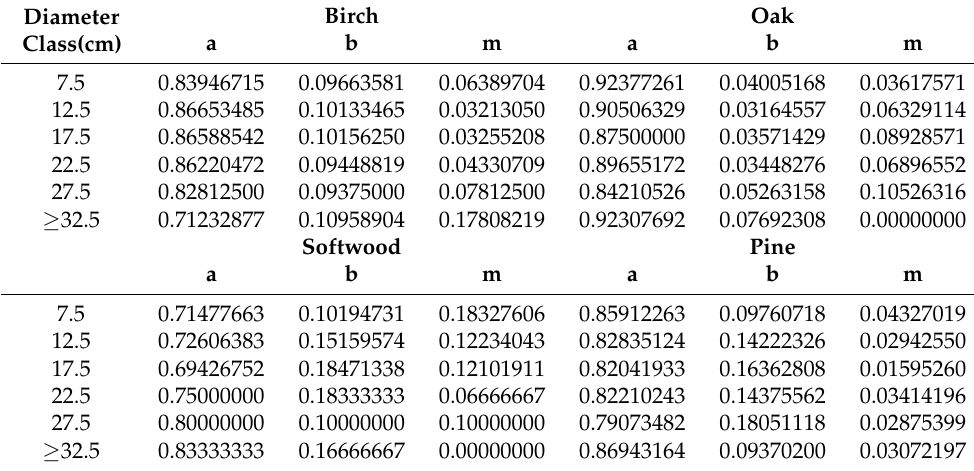
Table A4. Transition probabilities of each species group in each diameter